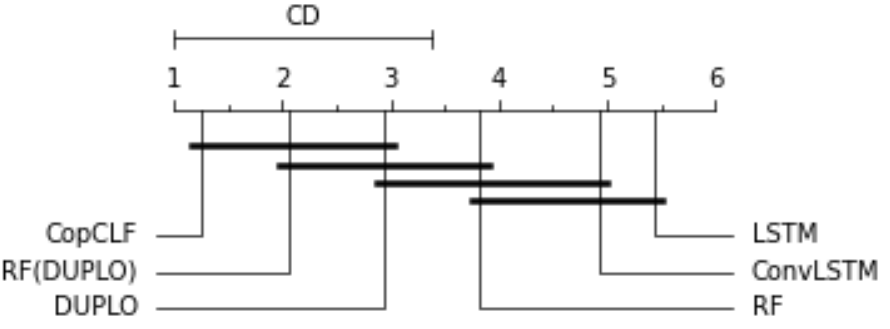
Figure 6. Comparison between Cop CLF , RF( DuPLO ), DuPLO , RF, LSTM and ConvLSTM with the Nemenyi test using the F-Measure average over 10 different random splits. The connected black line clusters the classifiers that are not significantly different at level p ≤